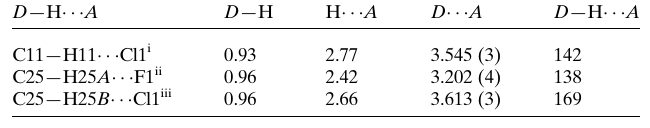
Table 2 Hydrogen-bond geometry (A˚ , (cid:2) ).